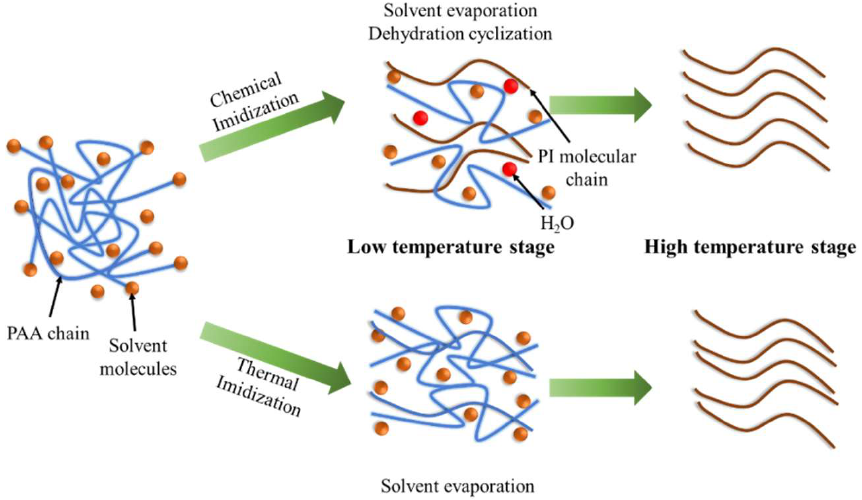
Figure 2 . Mechanism diagram of chemical and thermal imidization of PAA. Figure 2. Mechanism diagram of chemical and thermal imidization of PAA.